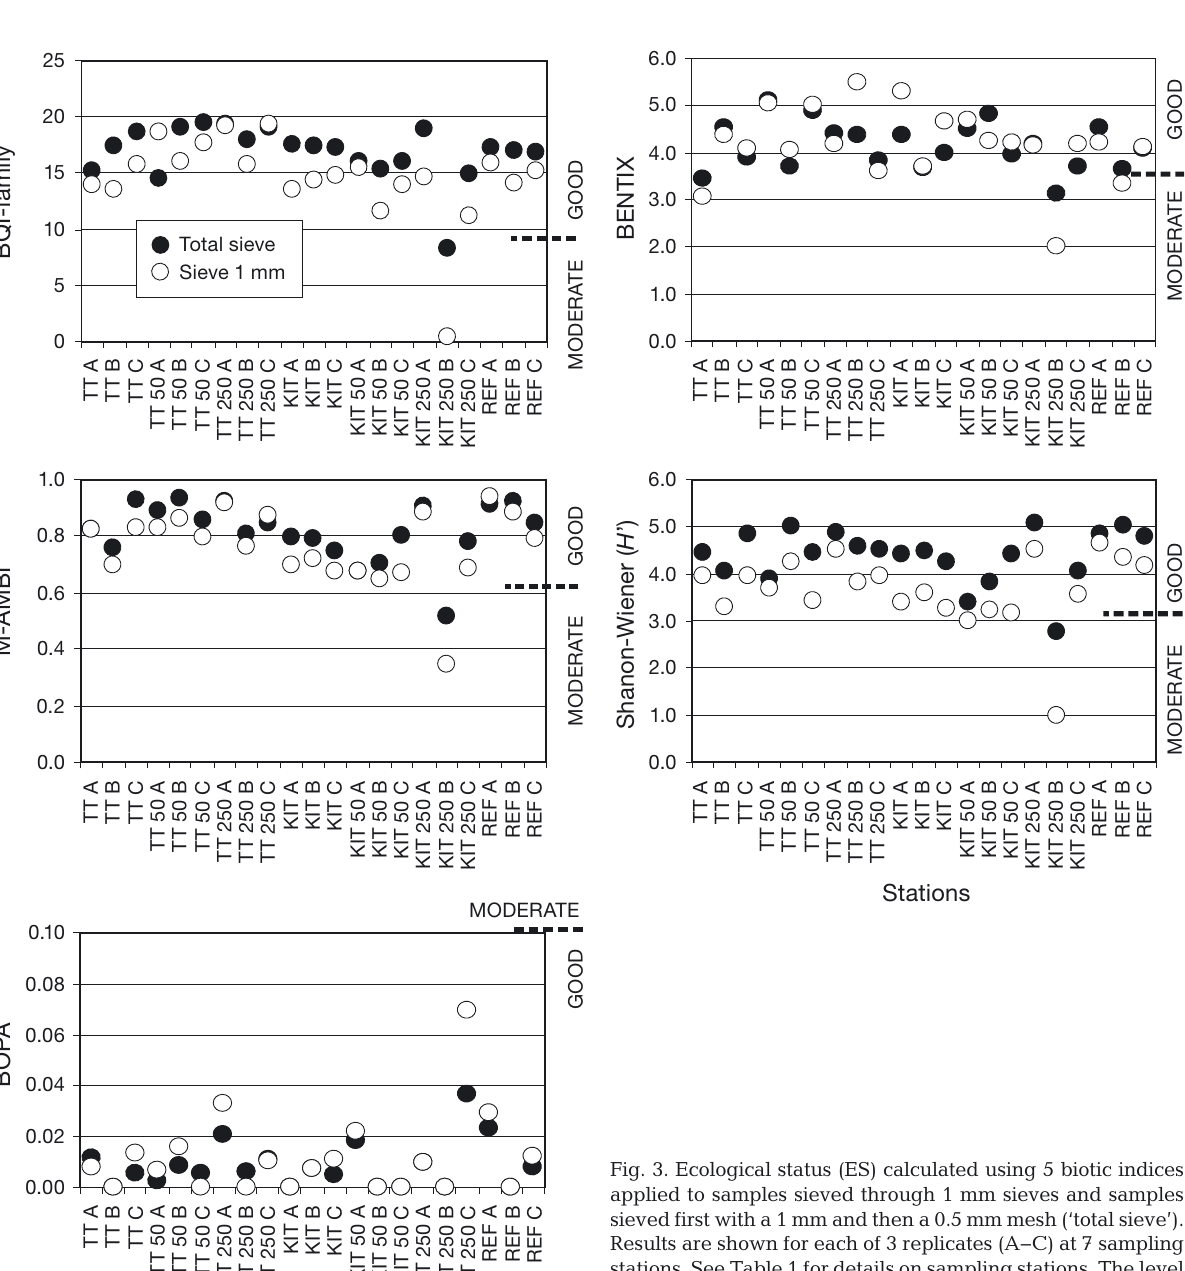
Fig. 3. Ecological status (ES) calculated using 5 biotic indices applied to samples sieved through 1 mm sieves and samples sieved first with a 1 mm and then a 0.5 mm mesh (‘total sieve’). Results are shown for each of 3 replicates (A−C) at 7 sampling stations. See Table 1 for details on sampling stations. The level separating ‘good’ and ‘moderate’ ES in the EU Water Frame- work Directive is shown for each index on the respective